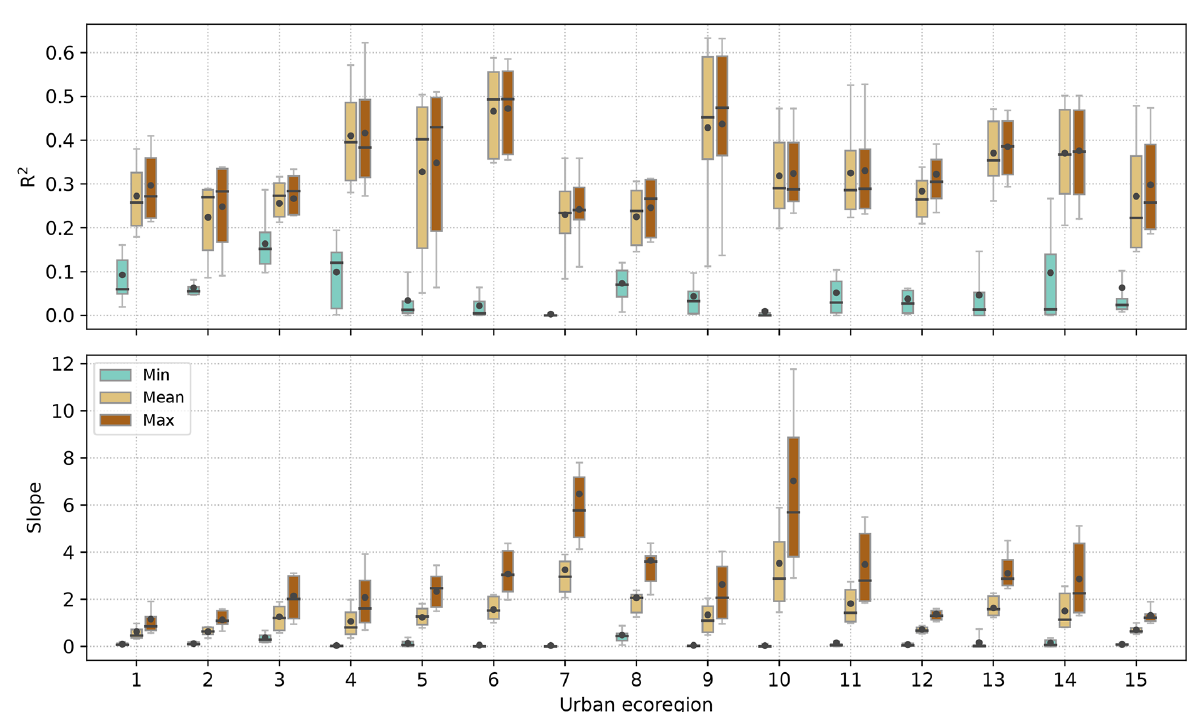
Figure I4. Like Fig. I2 but for the anthropogenic heat flux AHF.